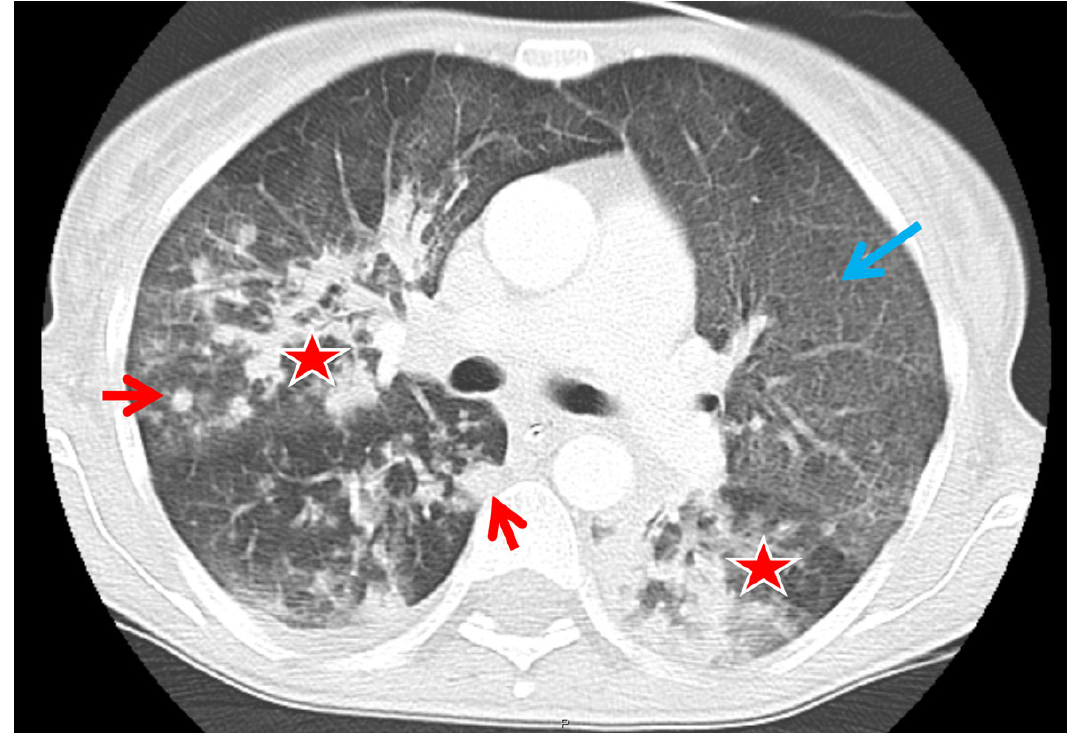
Figure 1: Axial computed tomography (CT) image from a renal transplant recipient. Typical CT image findings of a renal transplant recipient: patchy consolidations are found in the right upper lobe as well as in the apical segment of the left lower lobe (asterisk). There is also diffuse